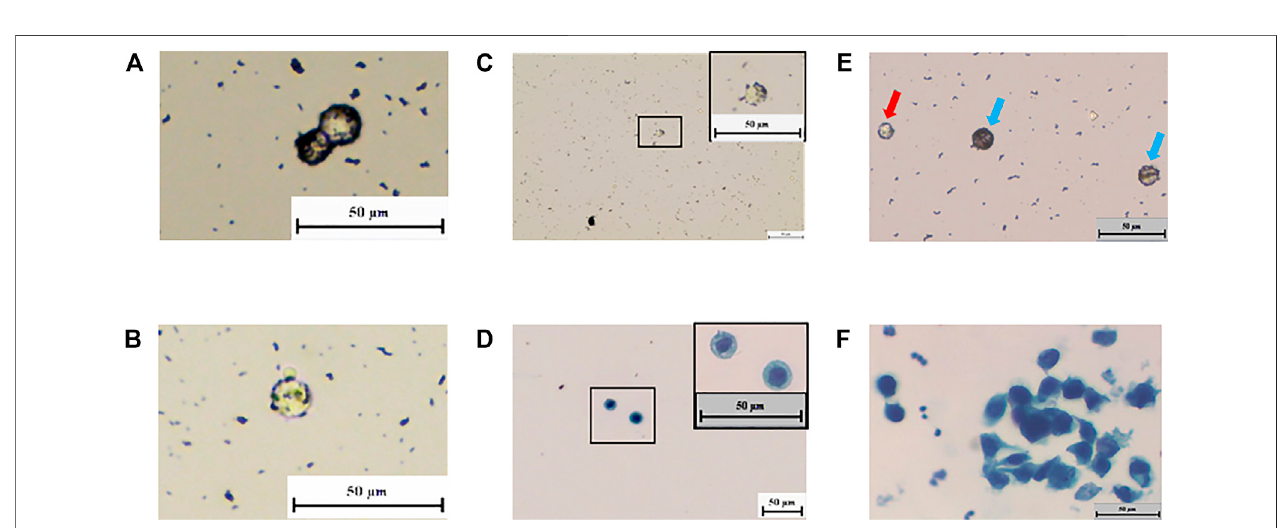
FIGURE4| “ Nanoring ” inlivingorganisms ’ bladdertumorcells. (A – C) Insubcutaneoustumorigenicmice ’ scellsandpatients ’ tissue,the “ nanoring ” phenomenon isobvious. (D) CytologytestprovestheNP-boundpatient ’ stissuecellsweretumor cells. (E) IncubatepositivemNPswithBladder cancerpatients ’ urineexfoliatedcells. “ Nanoring ” phenomenonisobvious.Whitebloodcell(redarrow)issmallerthanthebladdercancercell(bluearrow). (F) CytologytestprovesthattheNP-boundpatients ’ exfoliated cells were tumor cells.